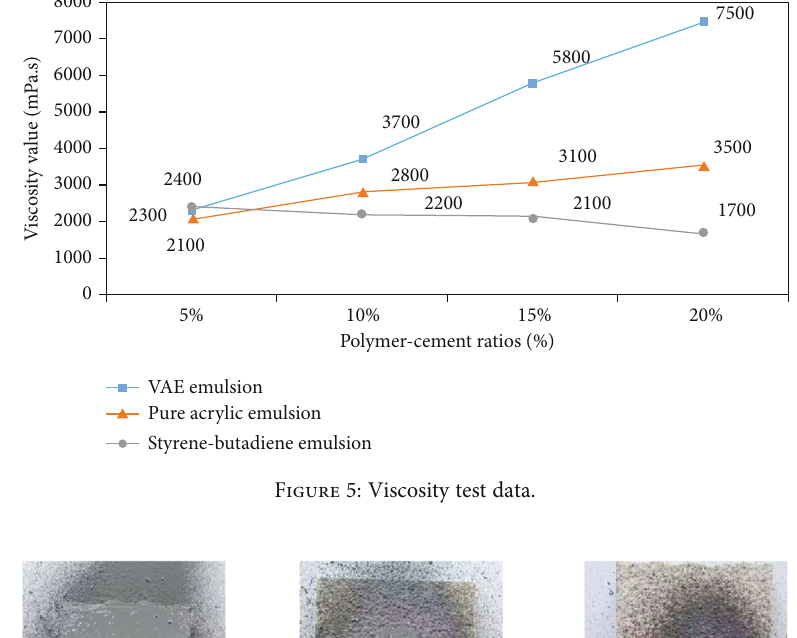
Figure 5: Viscosity test data.